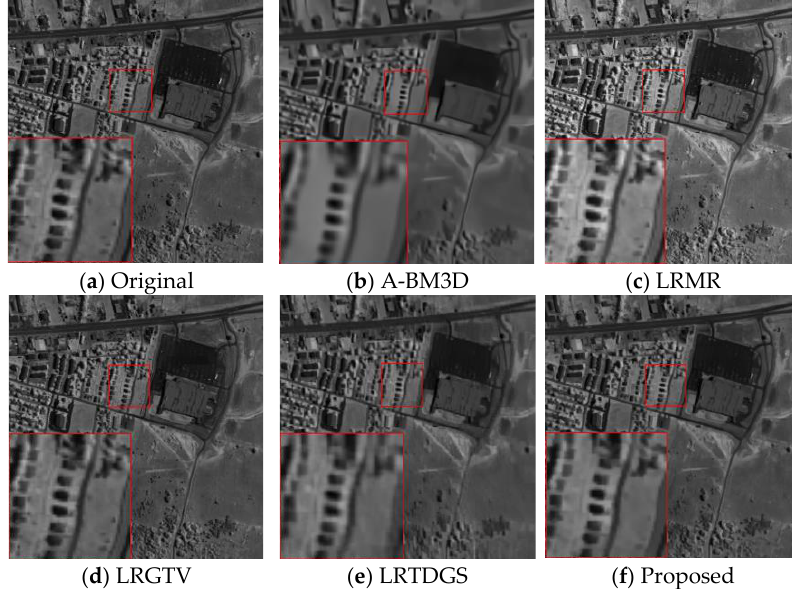
Figure 10. Restoration results on HYDICE urban image set: slight noise band.